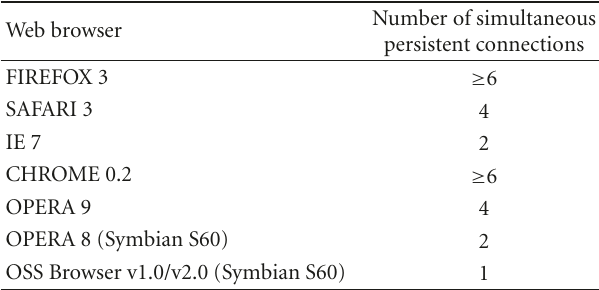
Table 2: Simultaneous persistent connections that a browser can